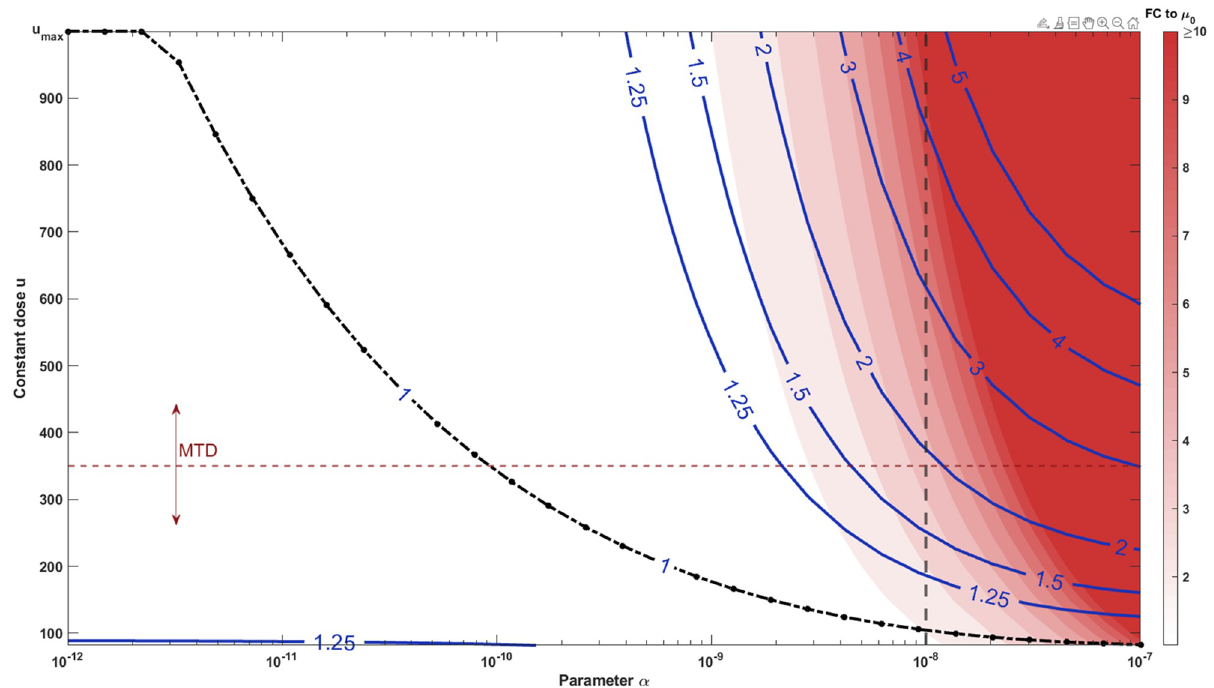
Fig 3. Optimal therapies substantially reduce the number of resistance mutations generated compared to MTD. The costs of constant therapies C ( u ; α ) were evaluated while varying the key parameter α , which quantifies the strength of dose-dependent mutation rate. The plotted contour lines correspond to the cumulative mutation intensities (the expected number of rescue mutants) relative to the optimal constant treatment C ( u ; α )/ C ( u � ; α ). Thus, the 1-isoline (drawn as black dash-dot line for emphasis) gives the optimal constant dose as a function of the parameter α , while the 2-isoline gives the cases where the corresponding MTD produces 100% more rescue mutations than the optimal dose. The red background color indicates the assumed fold change (FC) to the baseline mutation rate. We notice that substantial improvements are possible even for modest fold-changes depending on how well the drug is tolerated (how close the MTD is to u max ). The probability of evolutionary rescue scales exponentially in the amount of the rescue mutations. We consider the case α = 10 − 8 in detail, which corresponds to the cases given by the vertical dashed line. Similarly, the horizontal dashed line corresponds to the MTD used in stochastic